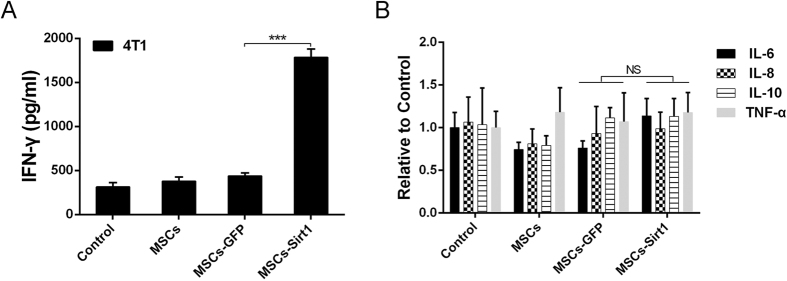
Serum inflammatory cytokines levels of mice suffered with subcutaneous tumors.(A,B) Serum inflammatory cytokines levels were determined by Bio-Plex ProTM mouse cytokine assay kit (Bio-Rad Laboratories, USA) at 18th day since cells subcutaneous injection. Each group consists of 5 mice. ***, P < 0.001; NS, P > 0.5.